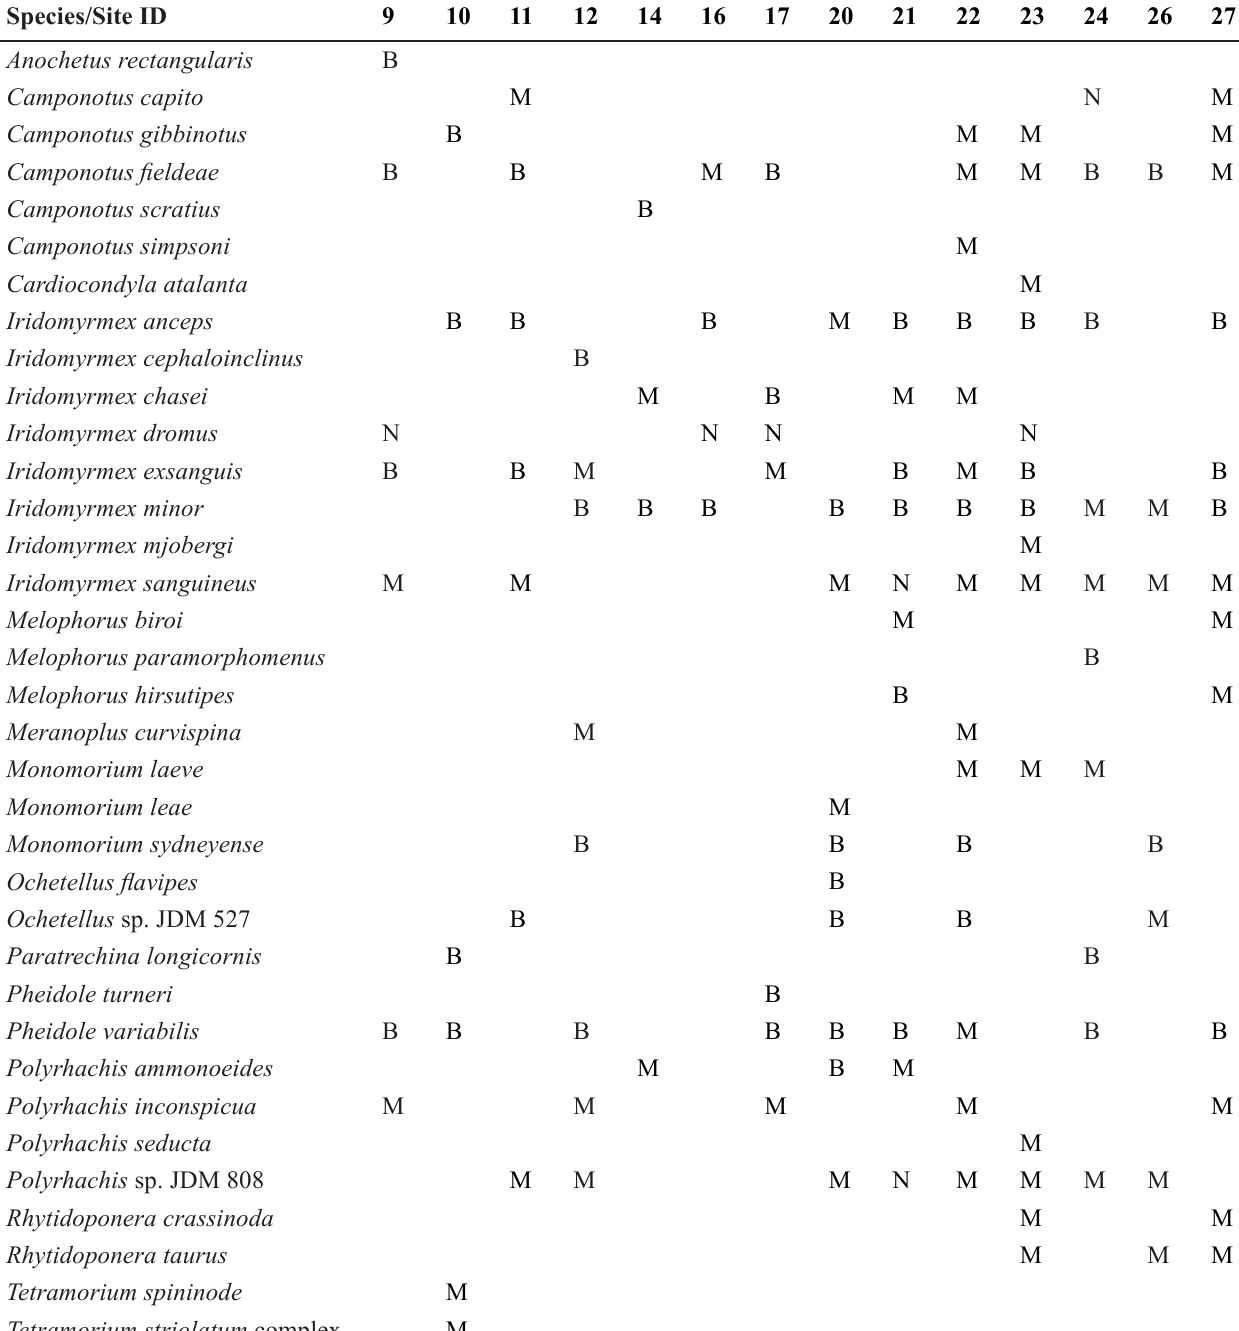
Table 3 . Comparison between morphological identification and molecular detection using Next Generation